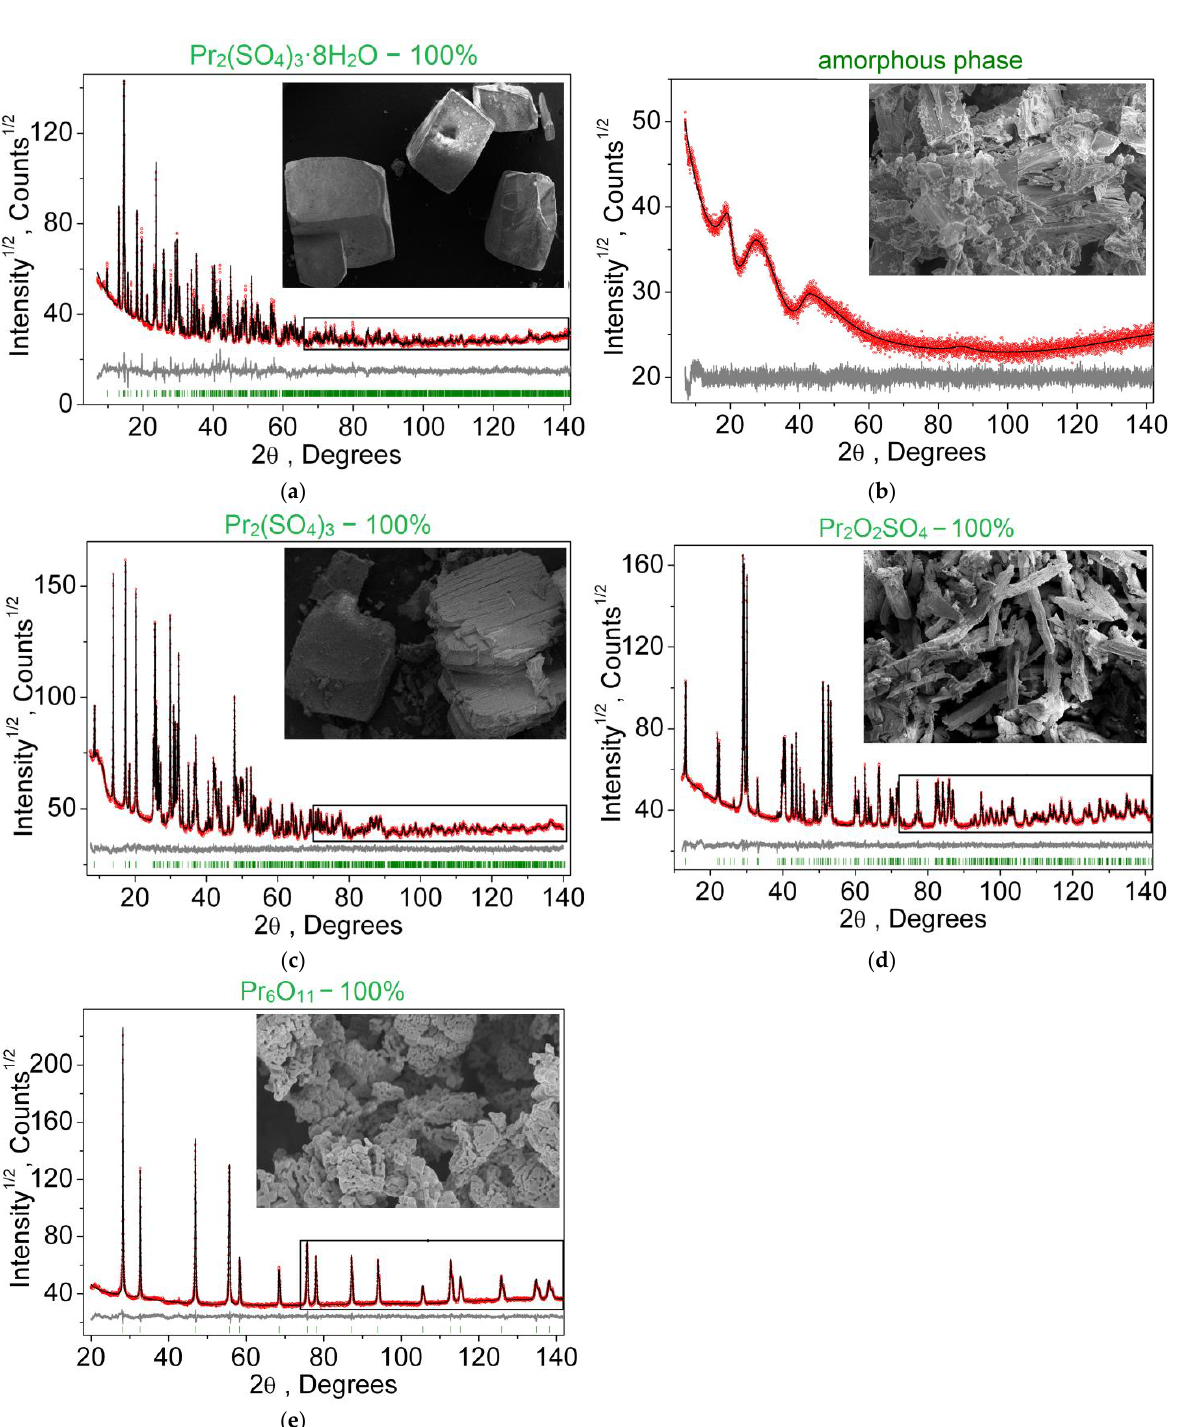
Figure 10. Difference Rietveld plots and microstructure transformation of polycrystalline samples Pr 2 (SO 4 ) 3 ·8H 2 O subjected to heat treatment at temperatures: ( a ) 25 °C (room temperature); ( b ) 250 °C; ( c ) 350 °C; ( d ) 1000 °C; ( e ) 1270 °C.